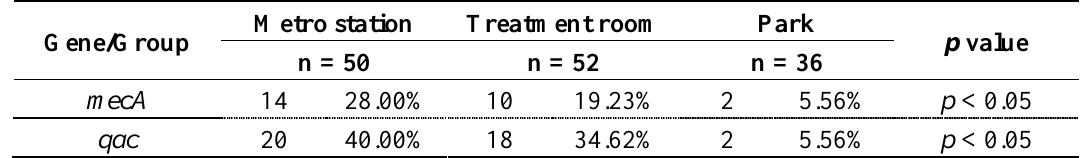
Table 2. Results from the detection of methicillin and disinfectant resistance genes. The presence of the mecA and qac genes were both significantly lower in the park samples compared to those from the metro and hospital ( p < 0.05).